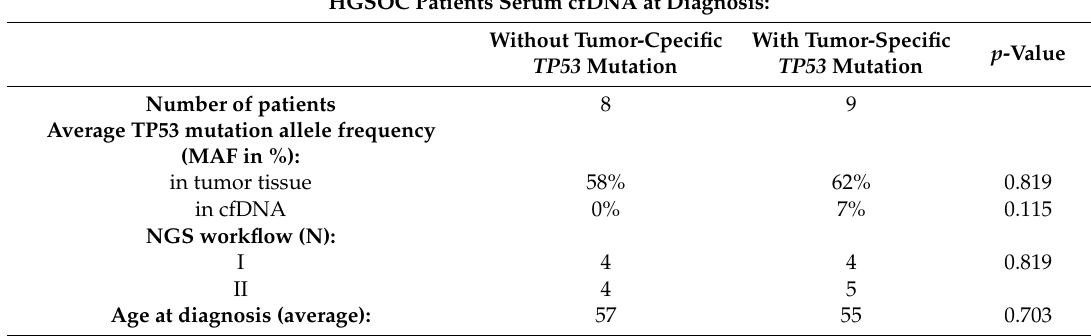
Figure 2. Serum cfDNA yields isolated from patients with advanced ovarian cancer. Boxplots presenting ( a ) amounts of cfDNA (ng / mL of serum) isolated at diagnosis for patients in relation to residual disease (RD; no or less than 1 cm vs. 1 cm or more) and ( b ) progression-free survival (PFS; ≤ 6 months and > 6 months). The individual measurements are shown as dots, the mean by the cross (x), and median as horizontal line within the box. The cfDNA amounts between the groups of patients were not significantly di ff erent. ( c ) Graph showing the Log cfDNA concentration (ng / mL of serum) isolated from 10 patients at three di ff erent time points. Data points correspond to total cfDNA yields per mL serum for each patient (Pt) at the three di ff erent time points from serum collection: At diagnosis (D), after chemotherapy (C), and at disease progression (P). Table 4. Comparison clinicopathological characteristics of high-grade serous ovarian carcinomas (HGSOC) patients with and without serum tumor-specific TP53 mutation at diagnosis. HGSOC Patients Serum cfDNA at